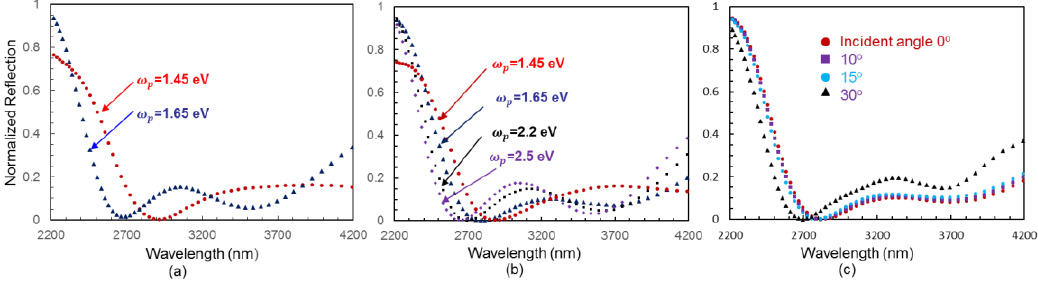
Figure 5. ( a ) Simulations of the reflection spectrum of a patterned AZO/glass spacer/metal thin film stack for a plasma frequency ω p of 1.65 eV (blue line) and 1.45 eV (red line) for the AZO; ( b ) Simulations of the reflection spectrum from patterned AZO/glass spacer/metal when the plasma frequency is changed to 1.65, 2.2 and 2.5 eV for 10 nm AZO near the AZO/glass interface while the plasma frequency is kept at 1.45 eV for the remaining part of the AZO layer with a thickness of 117 − 10 = 107 nm; ( c ) Simulations of the reflection spectrum with the plasma frequency of 1.45 eV, but with different incident angles of 0, 10, 15, and 30°.